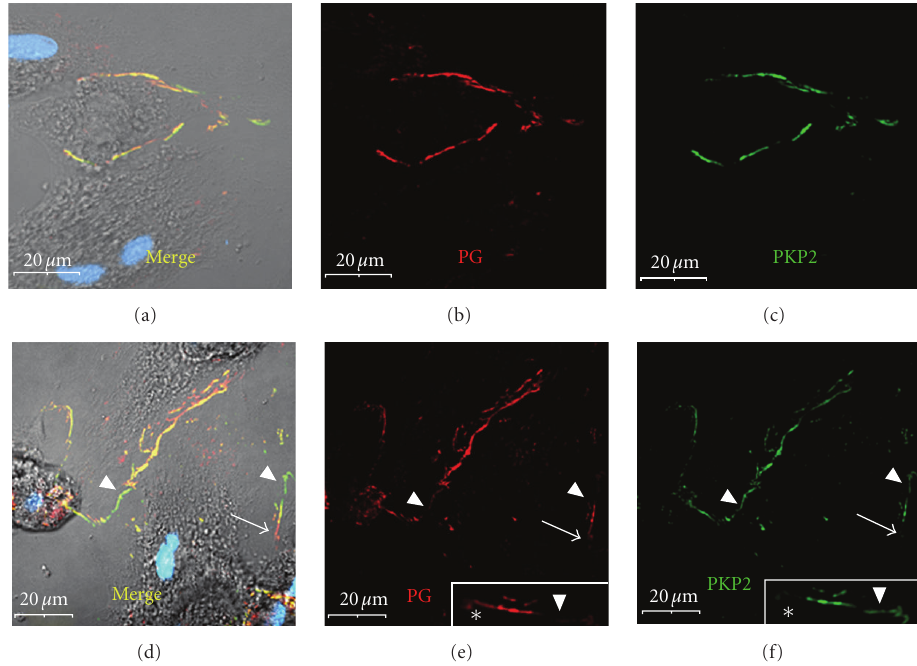
Figure 5: Localization of plakoglobin and plakophilin-2 in remodeling adult rat cardiac myocytes. ARCs were immunolabeled with antibodies to plakoglobin (PG) (red: a, b, d, e) and PKP2 (green: a, c, d, f) on day 5 post plating. Note the extensive co-localization of the two armadillo family proteins to new cell adhesion domains between contacting cells (a)–(c). There was some regional variation in the relative abundance of the two such that some newly-formed contacts contained predominately plakoglobin ((e): arrow; (e)-inset: asterisks) or PKP2 ((f) and (f)-inset: arrowheads). Scale bars are 20 μ m and the insets in (e) and (f) are a 2 × magnification of a region of